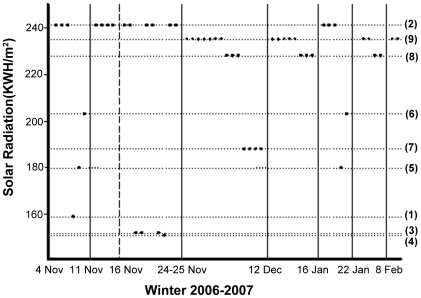
Monkeys were found in MAPs with highest solar radiation following snowfalls during the snowy period of our winter 2006–2007 survey.MAPs are arranged according to mean solar radiation and are indicated by number in parenthesis on the right vertical axis (Appendix S1, Table 1). Black dots indicate the locations of monkeys. Snowfalls are indicated by vertical lines and correspond to dates on the x-axis. The dotted vertical line indicates a short, 1–2 h snowfall during the day.